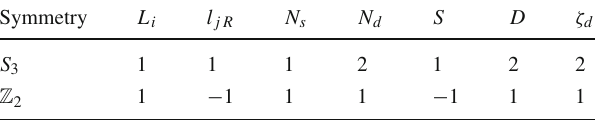
Table 2 Transformation properties of the fermion and scalar fields under S 3 and Z 2 symmetries. Quarks and charged leptons are singlets of S 3 and even under Z